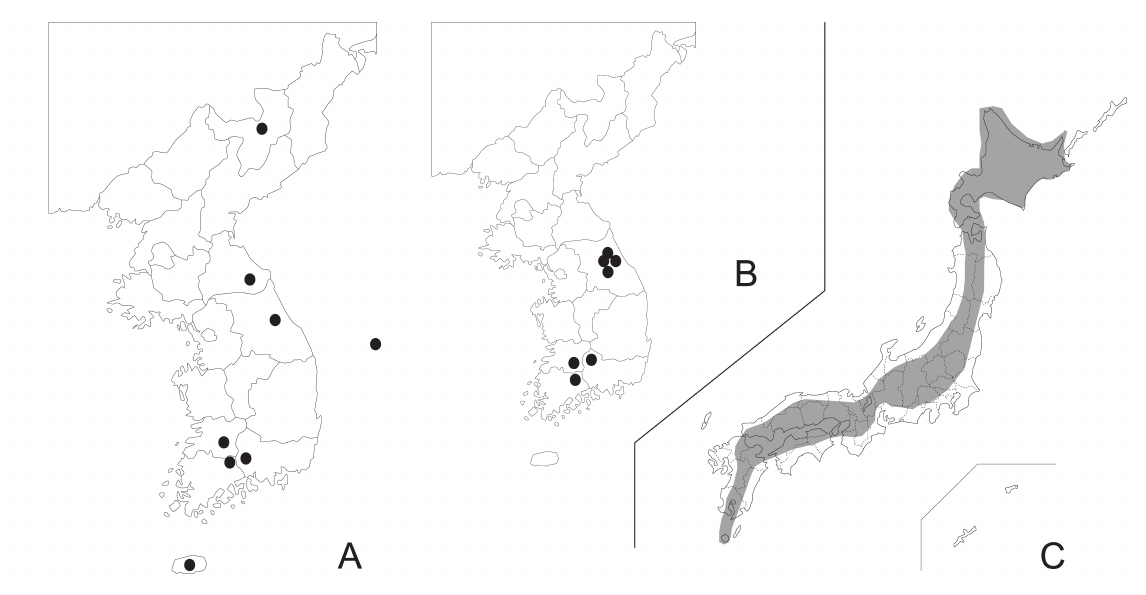
Fig. 22. distribution maps. A . Lasioglossum ( Dialictus ) ellipticeps (Blüthgen, 1923) in the Korean Peninsula. B–C . Lasioglossum ( Dialictus ) miyabei Murao et al ., 2006 (B in the Korean Peninsula, c in